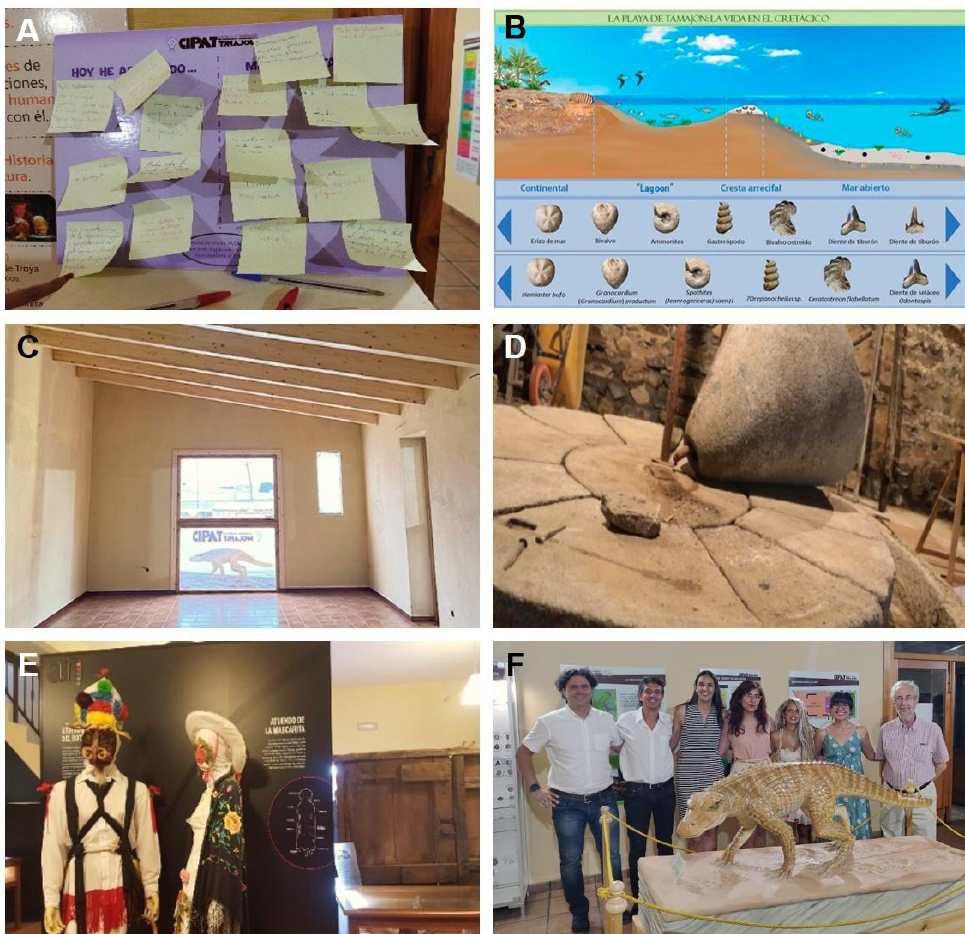
Figure 9. ( A ) Panel for qualitative feedback recollection to improve expositive materials and educational activities of the Paleontological and Archaeological Interpretation Centre of the locality (CIPAT); ( B ) Interface of the virtual educational activity “La playa de Tamajón - The beach of Tamajón”, showing two levels of difficulty; ( C ) Image of the extension of the CIPAT, for the future “Human Evolution Room” of the Archaeological Area; ( D , E ) The olive oil mill of Muriel ( D ); and the Botargas and Mascaritas Museum of Almiruete ( E ); which will be integrated with the CIPAT in a future tourist circuit along Tamajón and its districts; ( F ) Some of the members of the PaleoIbérica Research Group of the University of Alcalá, who have developed this project for the design and creation of the CIPAT, the inauguration day of this space to outreach the diversity and extraordinary value of scientific and cultural heritage of rural areas and promote geotourism.